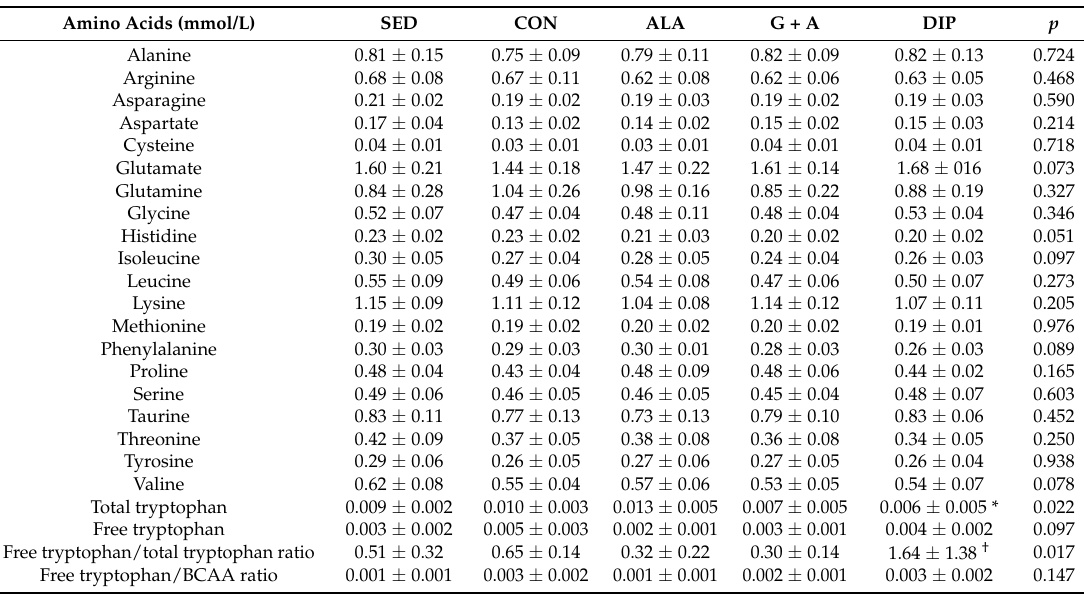
Table 2. Plasma concentrations in amino